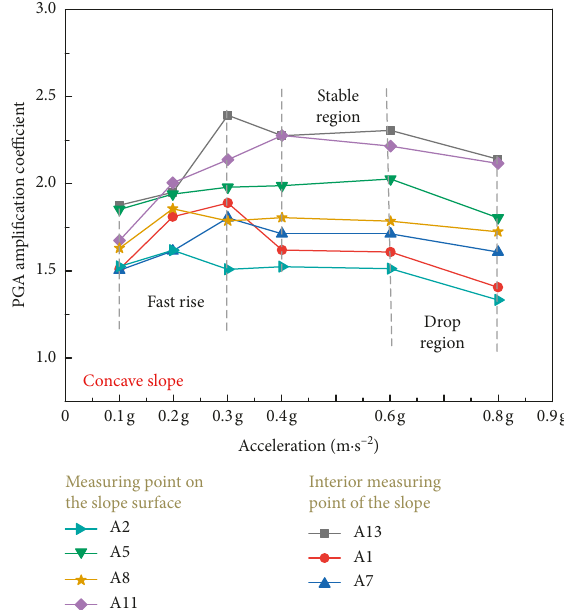
Figure 18: PGA amplification coefficients of concave slope under different El Centro